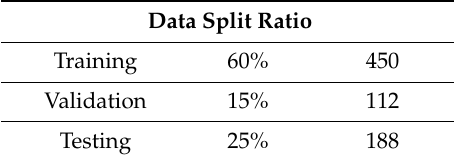
Table 3. Dataset samples used for